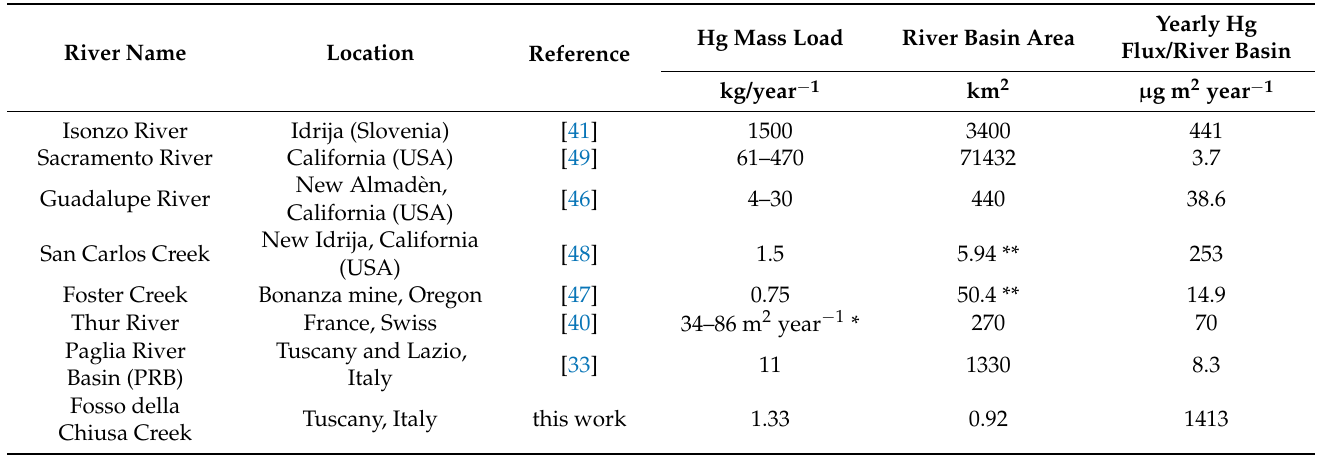
Table 5. Yearly mass load (kg/yr −1 ) of Hg from different rivers affected by Hg-rich ore deposits, along with river basin area and specific mass load (yearly mass load divided by basin area) data.